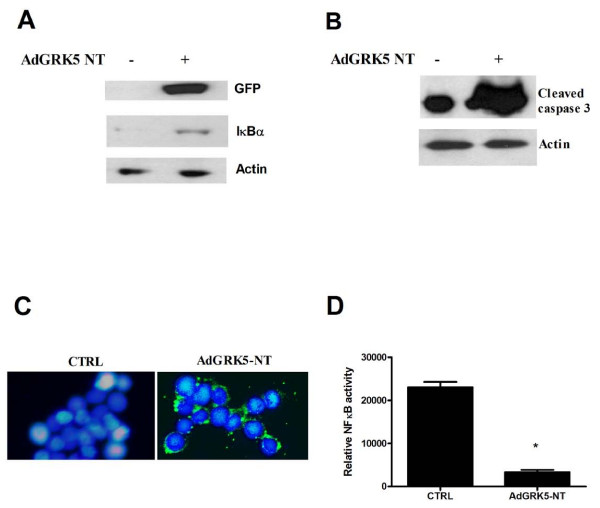
Effects of GRK5-RH in vitro in KAT-4 cells overexpressed by adenovirus mediated gene transfer. A) IκBα and GRK5-RH levels were analyzed in whole extracts by western blot, in KAT-4 overexpressing GRK5-RH by means of adenovirus mediated gene transfer. GRK5-RH increases IκBα levels. GRK5-RH expression was visualized by WB using anti-GFP antibody. B) To evaluate GRK5-RH effect on apoptosis, we analyzed the cleavage of caspase 3 by WB. The overexpression of GRK5-RH increases cleaved caspase 3 levels, suggesting that GRK5-RH causes an increase of apoptotic responses. C) This result was confirmed by Annexin V staining in fluorescence. GRK5-RH overexpression causes apoptosis as shown by Annexin-V staining compared to live cells (green = Annexin V; blue = nuclei) D) We evaluated GRK5 effects on NFκB activity by luciferase assay, in KAT-4 overexpressing GRK5-RH. Cells were transfected with plasmids coding for a κB-luciferase reporter (κB-Luc) and β-galactosidase (β-Gal) and lysates were analyzed by luciferase assay system (Promega). GRK5-RH inhibits NFκB transcriptional activity (*p < 0.05 vs control).